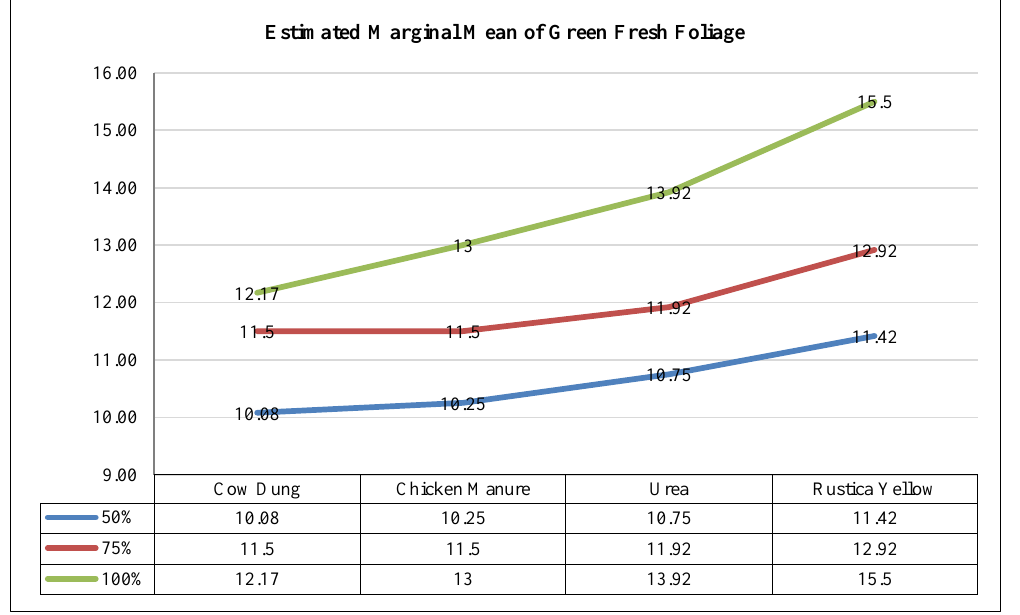
Figure 5. Nitrogen Sources Effect and Levels on Fresh Forage Production of King Grass